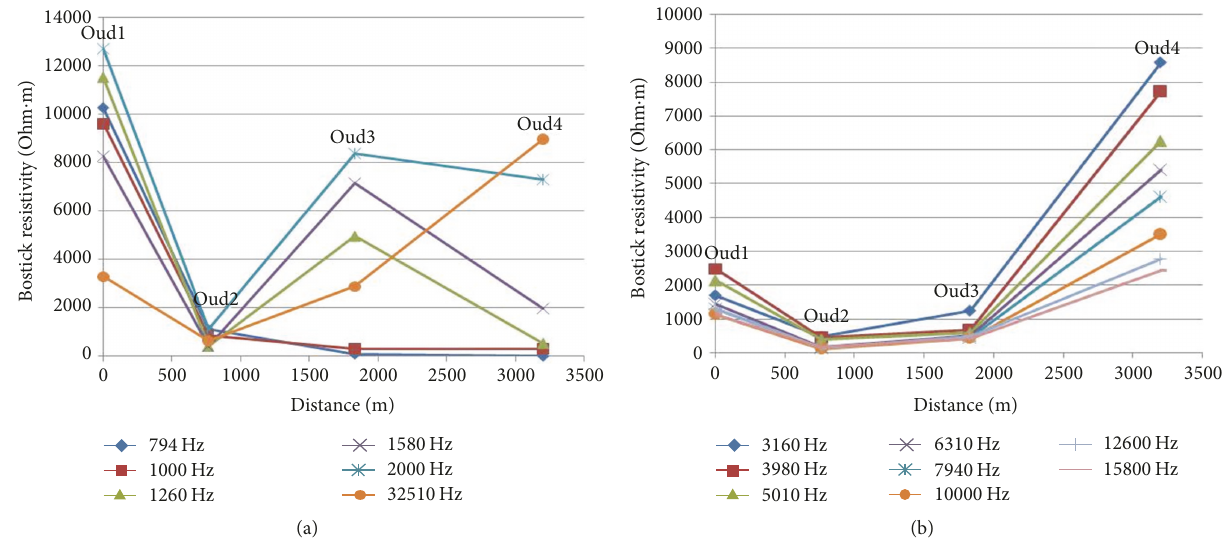
Figure 9: Resistivity profiling curves for Oudou profile at low frequencies [ 794 Hz–2000 Hz] (a); resistivity profiling curves for Oudou profile at high frequencies [ 2510Hz–15800 Hz]